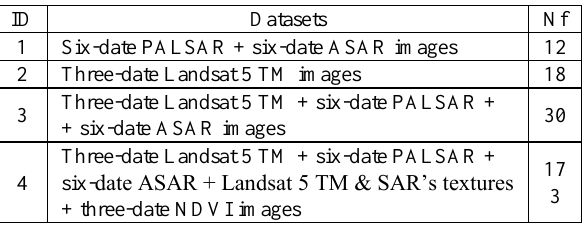
Table 2. Combined datasets for land cover classification in Appin area; Nf is number of input